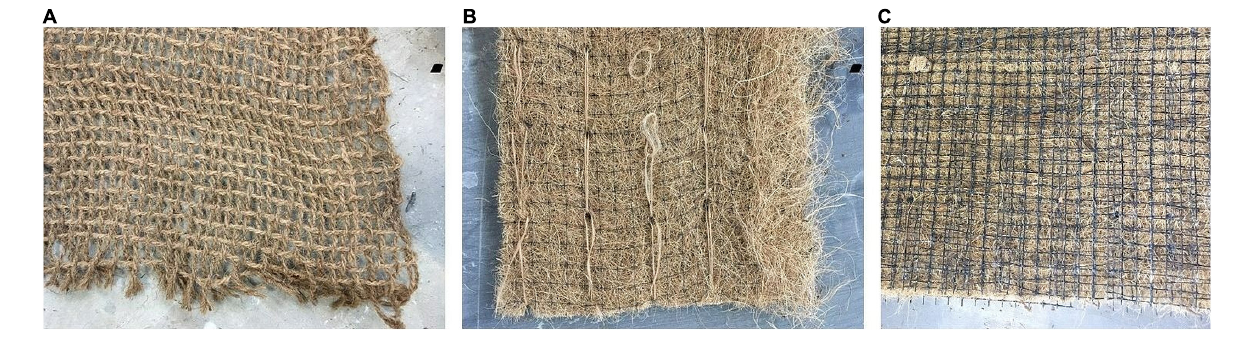
FIGURE 3 | Coir mats from Greenfix used for testing without artificial seagrass. (A) CN700: Coir netting made of woven coir fiber (CM1), (B) Eromat 7H: Coir fiber encompassed by thin polypropylene (PP) (CM2). (C) Eromat 75C: Coir fiber encompassed by high-density polyethylene (HDPE) (CM3). An indication of size is given in Table 2